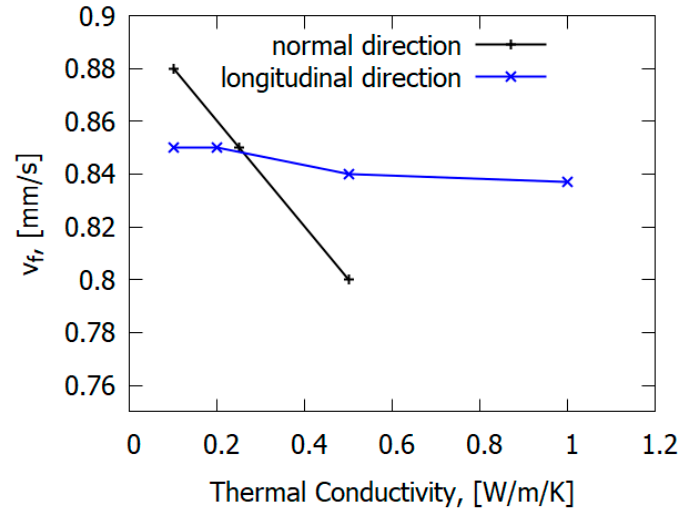
Figure 23. The effect of thermal conductivity in the longitudinal direction and in the normal direction on the flame spread rate over GFRER.